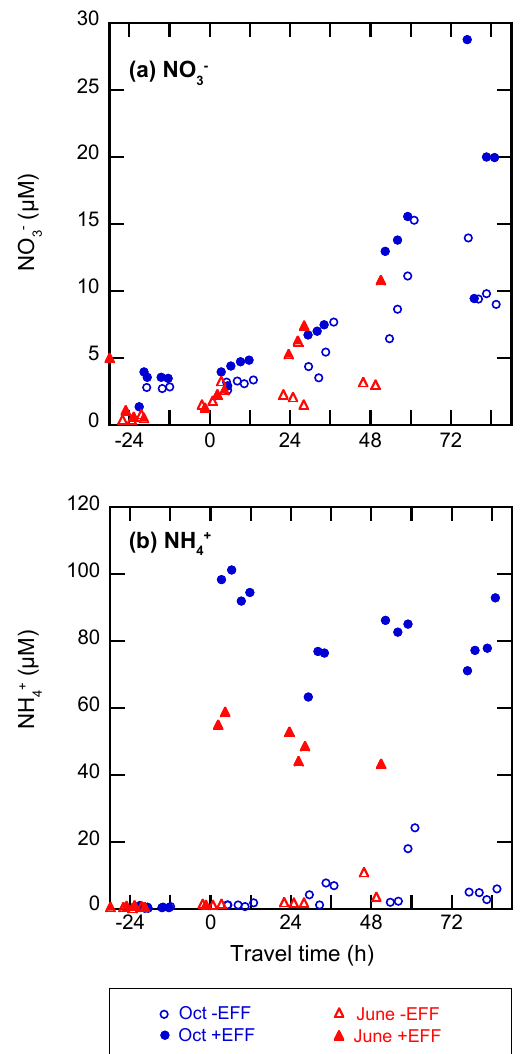
Figure 2. Concentration of NO − (a) and NH + (b) in samples col- 3 4 lected during the October and June Lagrangian experiments from parcels that either received effluent ( + EFF) or did not receive efflu- ent ( − EFF) as they traveled past the WWTP. Samples are plotted by travel time, where zero represents the time the parcel passed the location where effluent high in NH + enters the 4